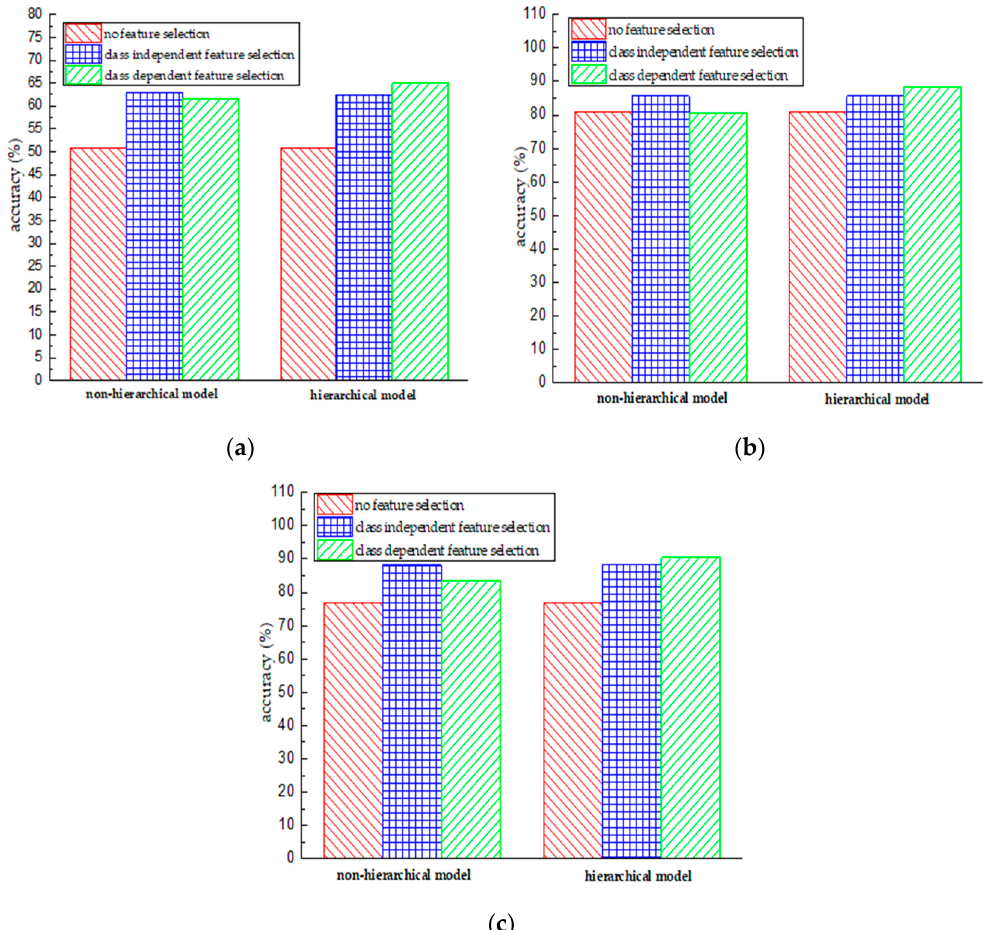
Figure 8. Performance comparison of using different feature selection methods in the case of the non-hierarchical model and hierarchical model. ( a ) Performance obtained using the gyroscope data; ( b ) Performance obtained using the accelerometer data; ( c ) Performance obtained using the accelerometer & gyroscope data.